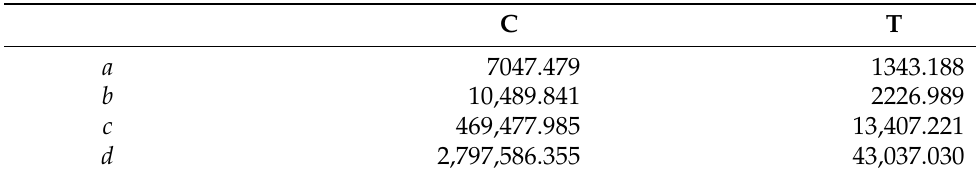
Table 2. Parameters defining analytical description of electron hopping probability at the collinear (C) and T-shaped (T) orientations, Equation (8). Units of a and b are m 2 /s 2 , while those of c and d are m 4 /s 4 .